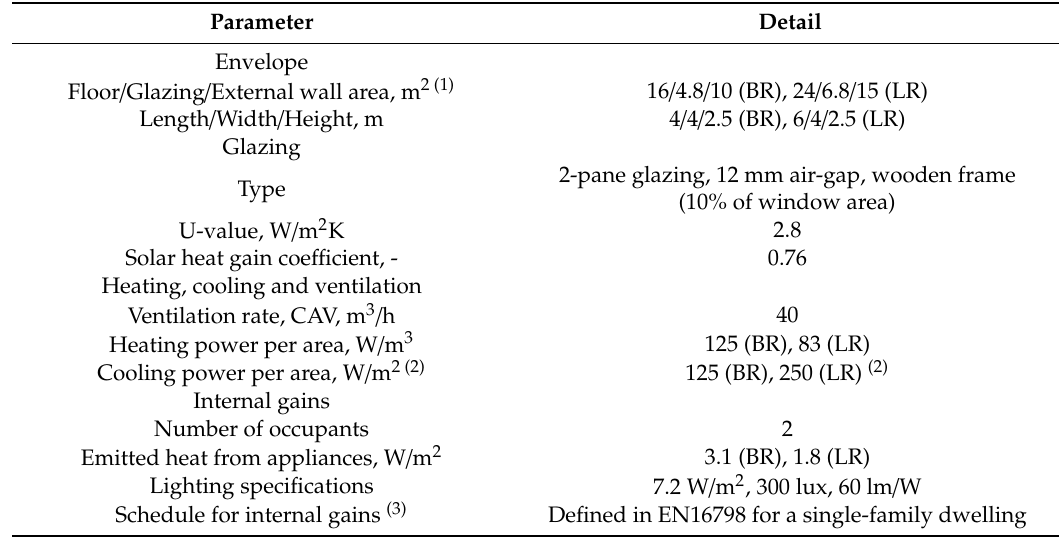
Table A1. Main parameters included in the building simulation model corresponding to a single-family house with a bedroom (BR) and a kitchen-living room (LR). (1) All external walls were south-facing. (2) Only considered for the model located in Abu Dhabi. (3) The schedules for were adopted from